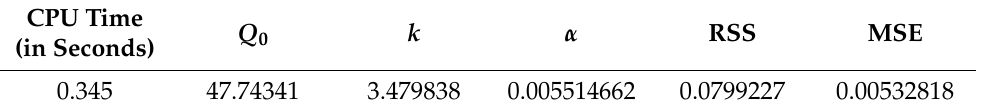
Table 2. Result of implementation of nlstac for pattern (12). RSS denotes residual sum of squares, and MSE = RSS / n where n = 15 is the number of